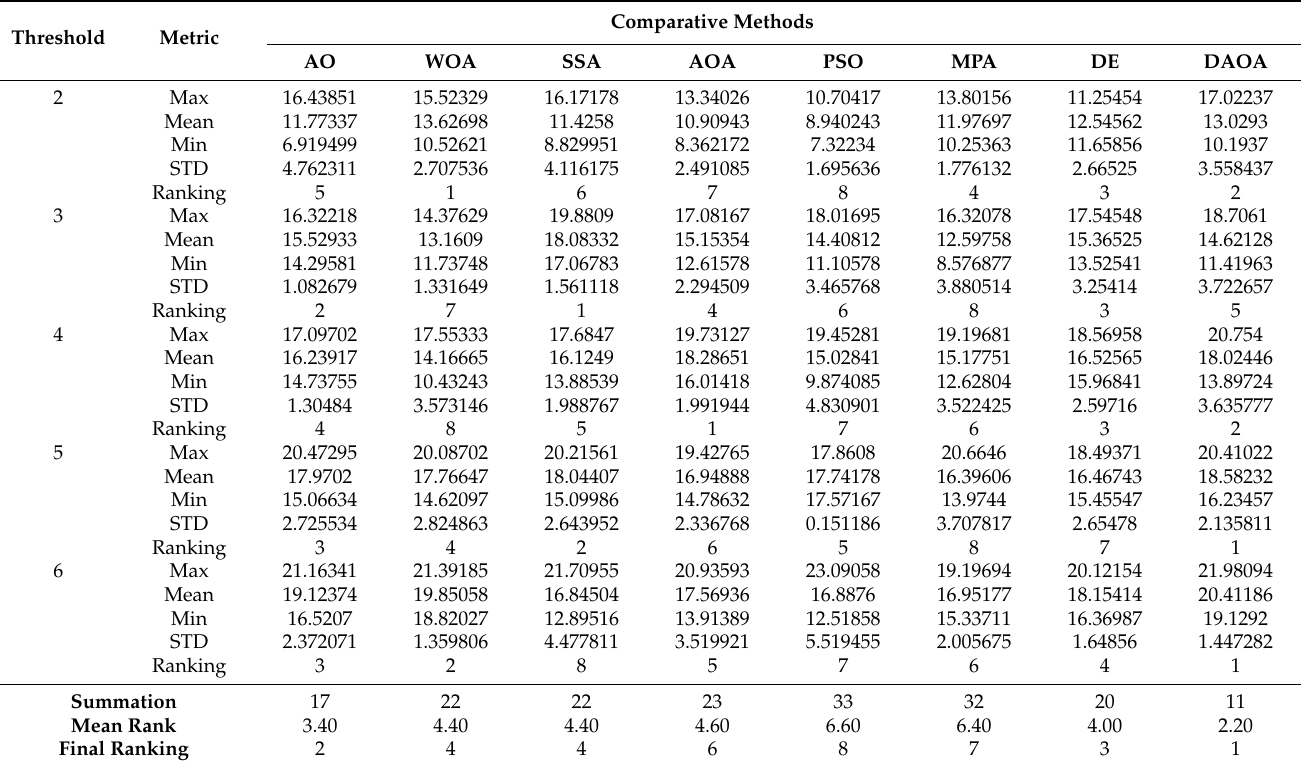
Table 6. The PSNR results of the test case 3.